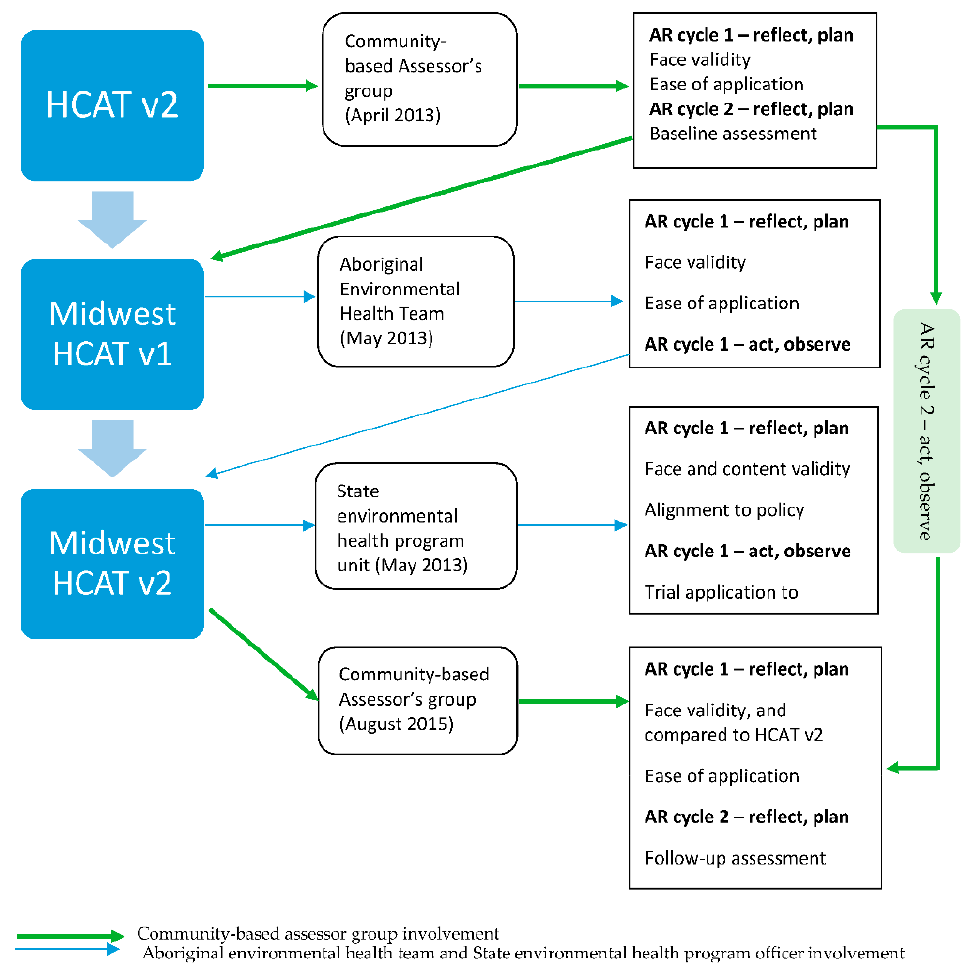
Figure 1. Process of validating the Healthy Community Assessment Tool version